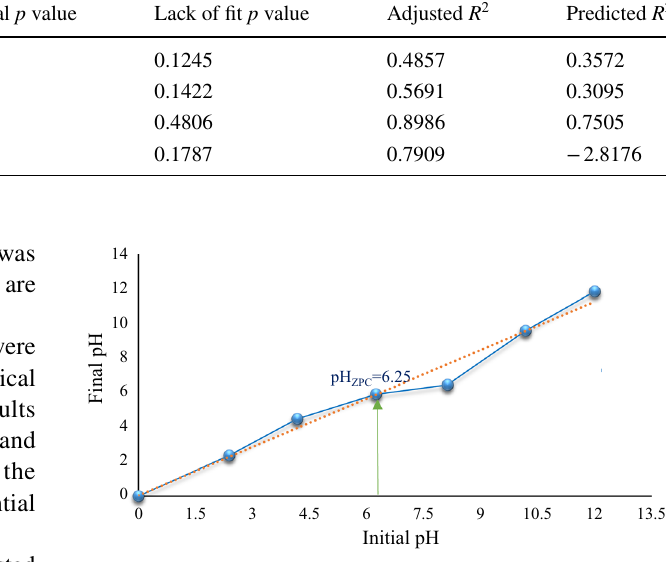
Fig. 4 The impact of pH on zeta potential of the γ -Al